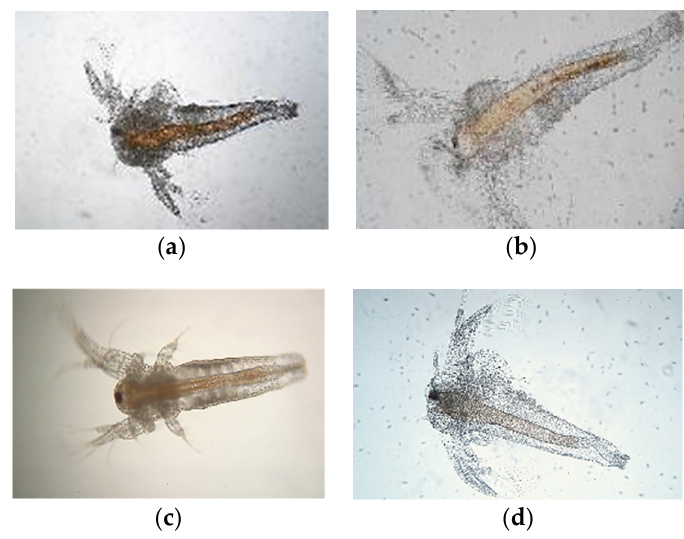
Figure 8. Artemia salina nauplii: nauplii exposed to bare CeO 2 for 24 hours ( a ), nauplii exposed to bare CeO 2 for 48 hours ( b ), control at 24 hours ( c ), control at 48 hours ( d ).